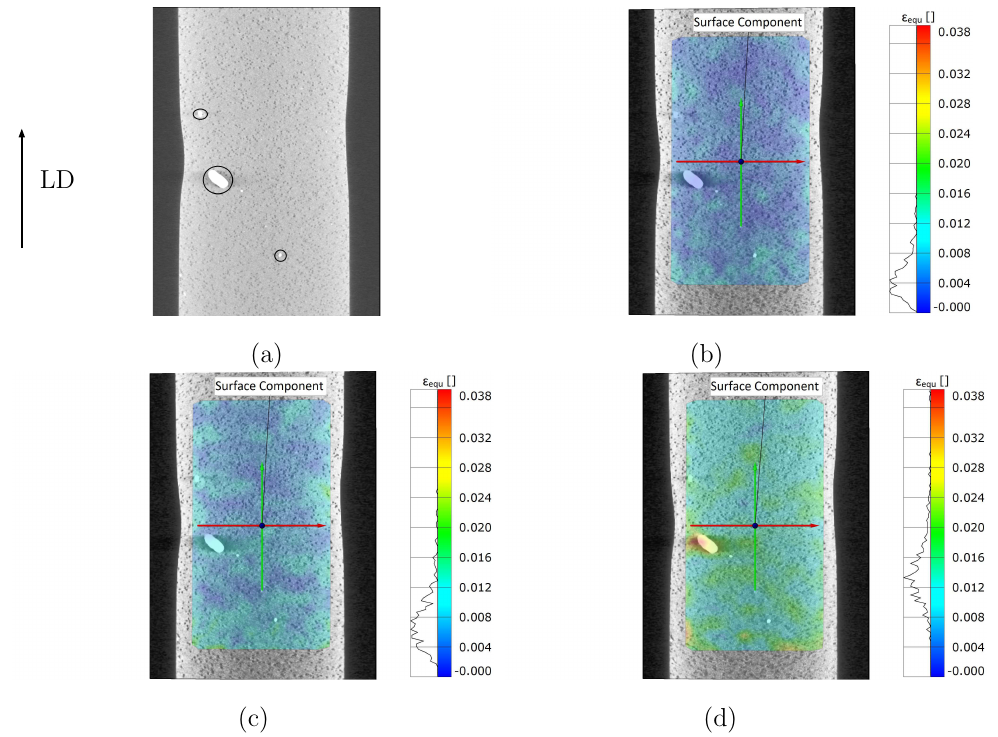
Figure 8. Stress controlled tensile loading: ( a ) in-situ X-ray µ CT images at the load of 0N; ( b – d ) strain maps (von Mises) calculated by digital image correlations (GOM [59]) at loading 2000 N, 3800 N and 4600 N, respectively.